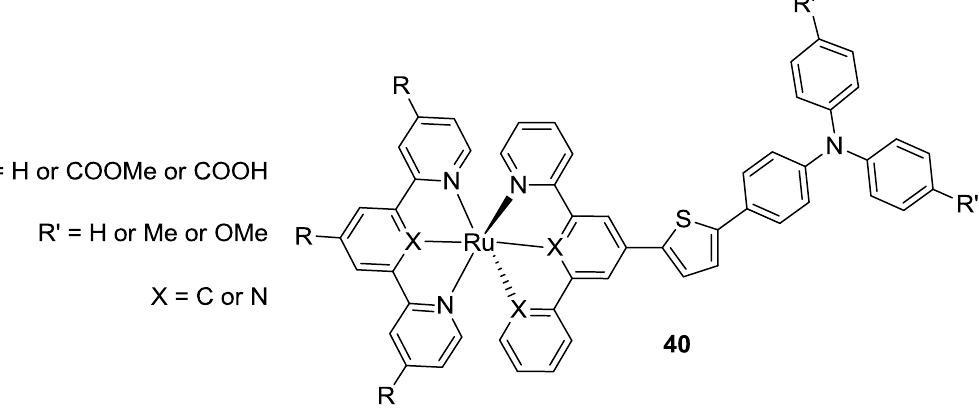
Figure 30. Robson et al. [136] series of bis-tridentated ruthenium complexes bearing triphenyl amino groups.